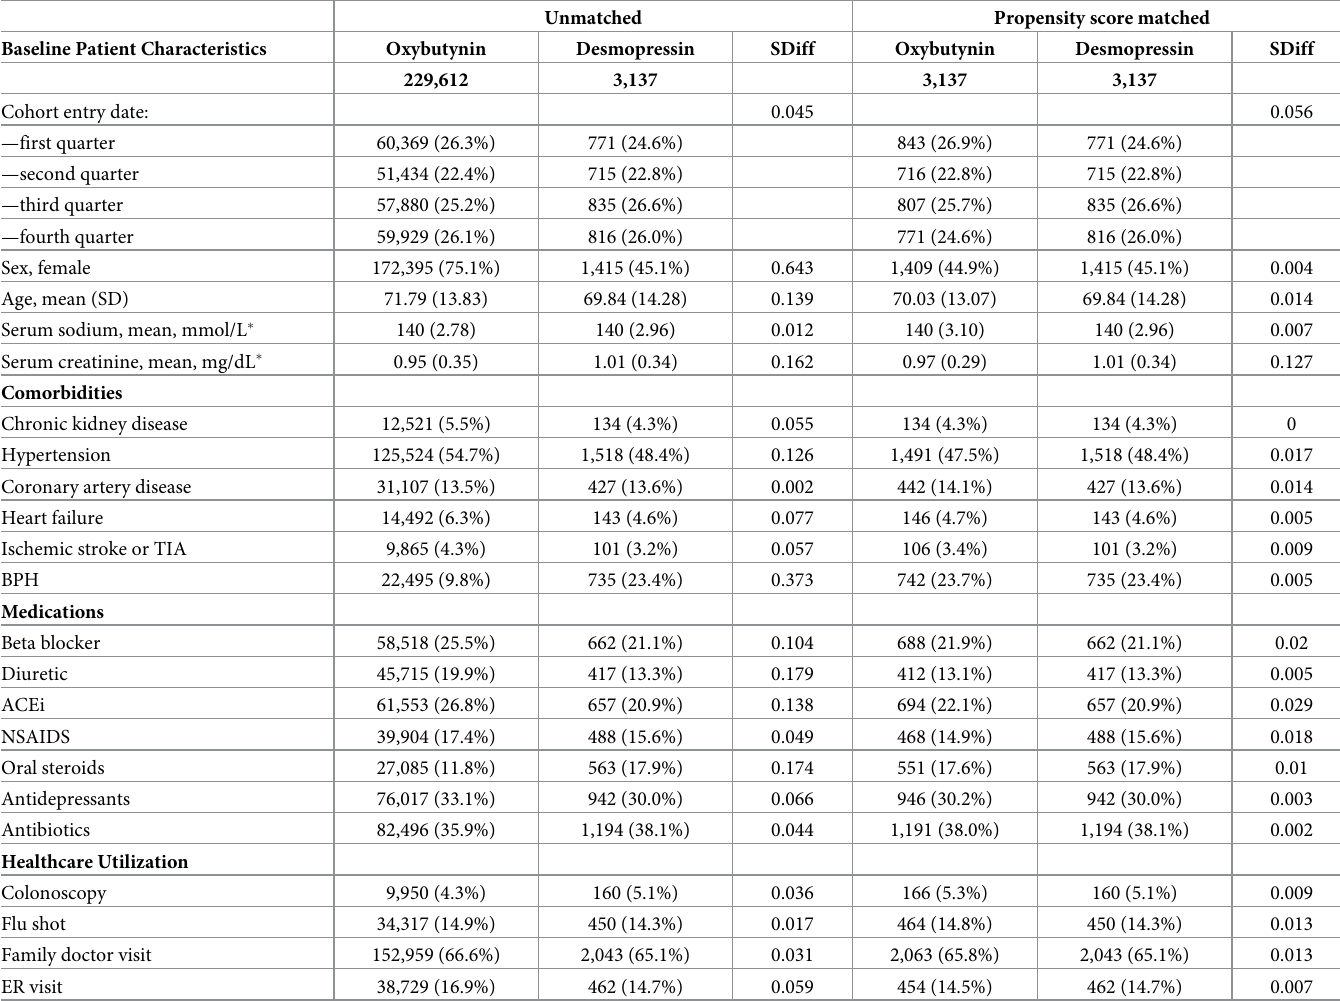
Table 1. Baseline patient characteristics.